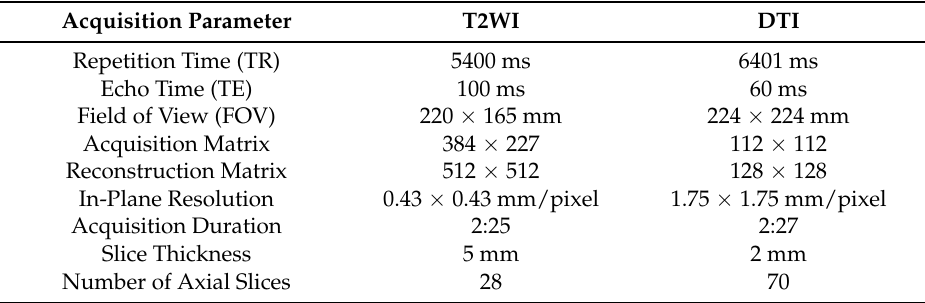
Table 1. Acquisition Parameters for T2WI and DTI.